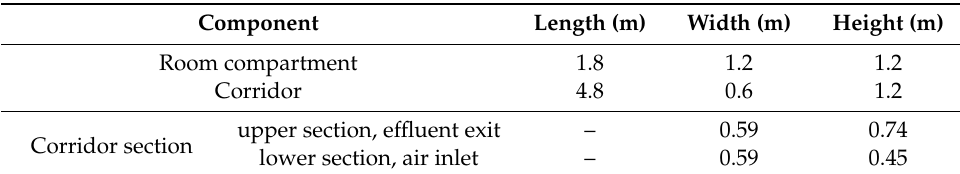
Table 3. Room-corridor rig